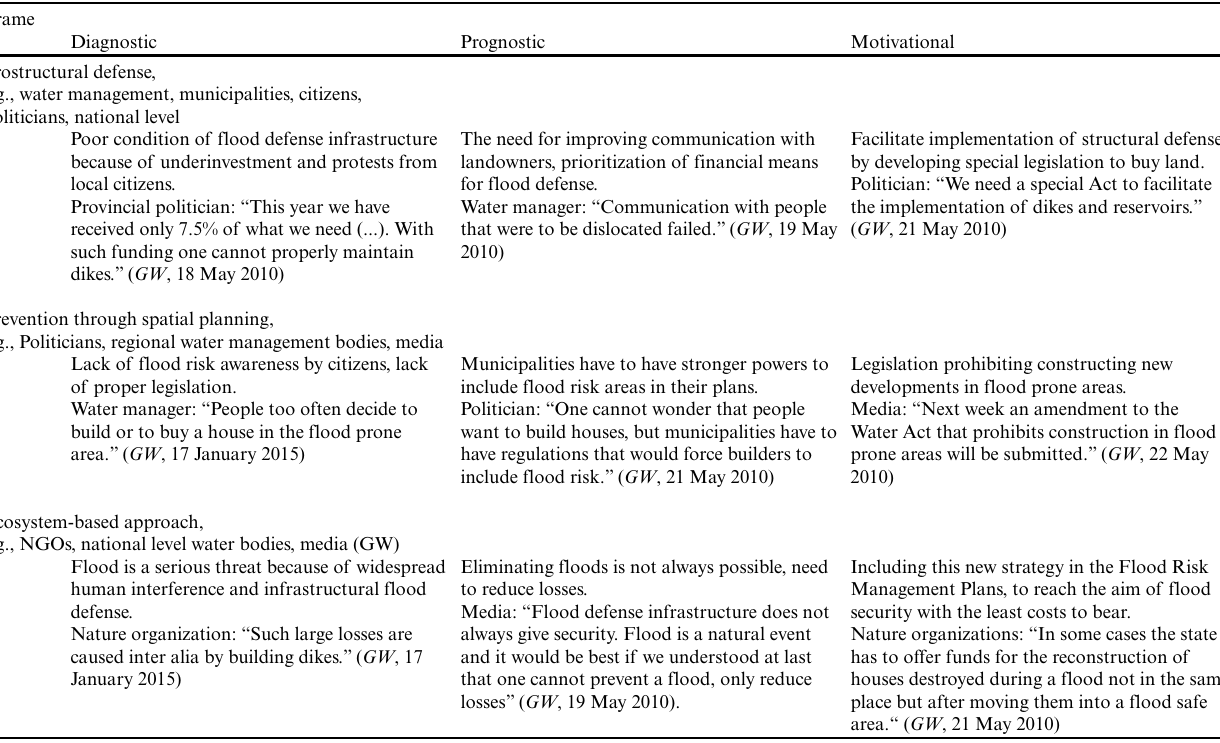
Table 10 . Overview of frames identified after the flood of 2010 with representative quotations. Frame Diagnostic Prognostic